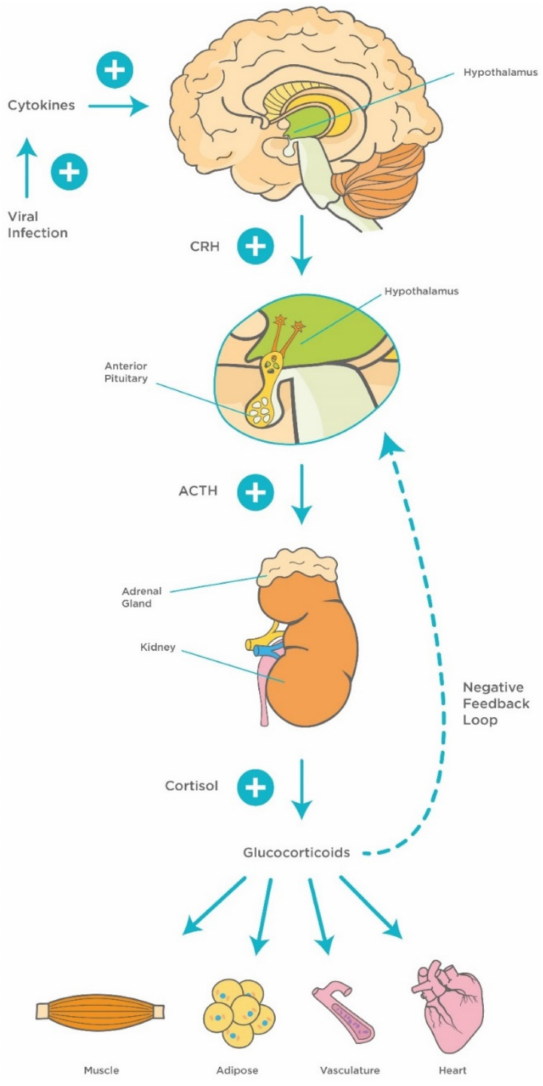
Figure 3. Mechanisms of hypothalamic–pituitary–adrenocortical (HPA) axis during viral infection. Viral infection activates innate proinflammatory cytokines (TNF- α , IL-1, and IL-6) and interferons, and late acquired T cell cytokines (IL-2 and IFN- γ ), which activate the HPA axis and release of GCs. This, in turn, stimulates a negative feedback loop to control the immune response. Abbreviations: ACTH, adrenocorticotropic hormone; CRH, corticotropin-releasing factor, TNF- α , Tumor Necrosis Factor-alpha; IL-1, Interleukin-1; IL-6, Interleukin-6; IL-2, Interleukin-2; IFN- γ , Interferon-gamma; GCs,